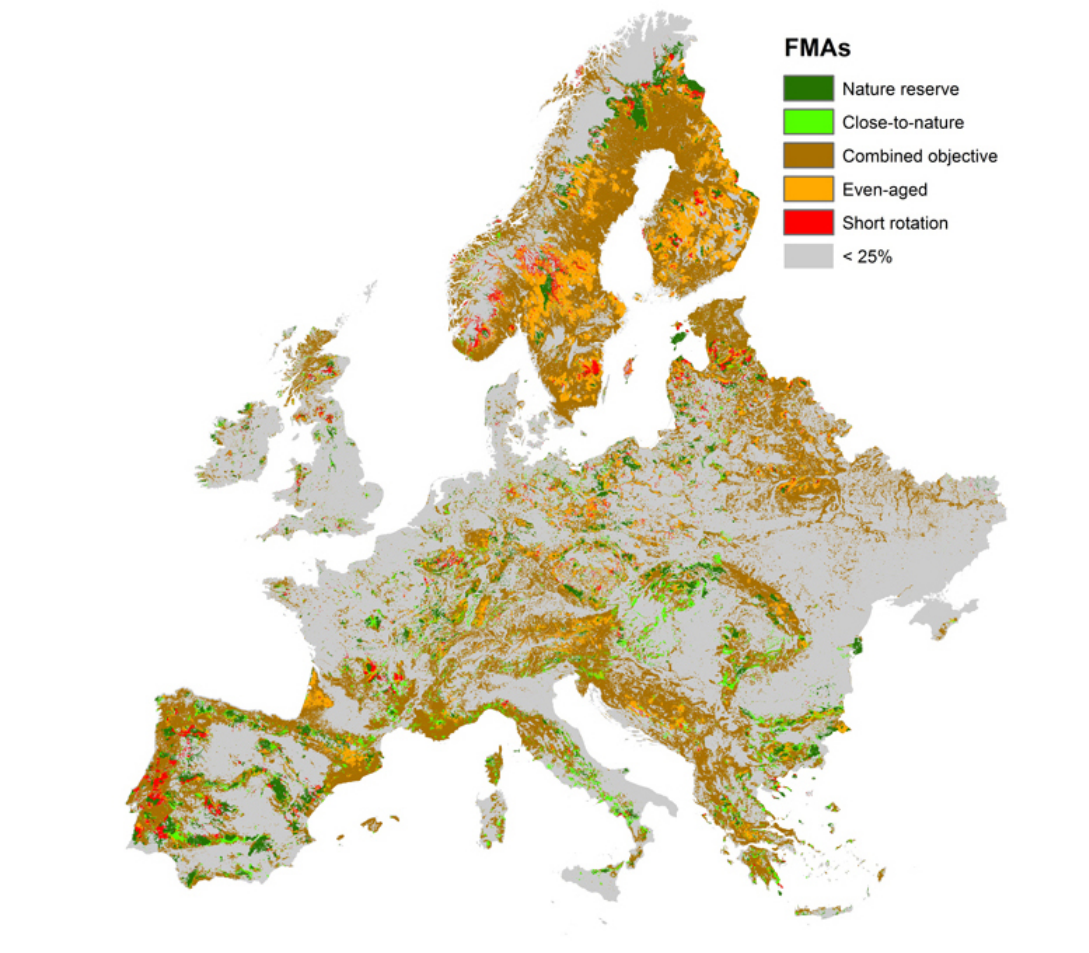
Fig. 2 . Dominant forest management approach (FMA) in Europe. Distribution of FMAs according to dominant suitability per 1-km 2 pixel, using parameters from Table 2. Results are shown for pixels with more than 25% forest cover. For a definition of dominant suitability, see